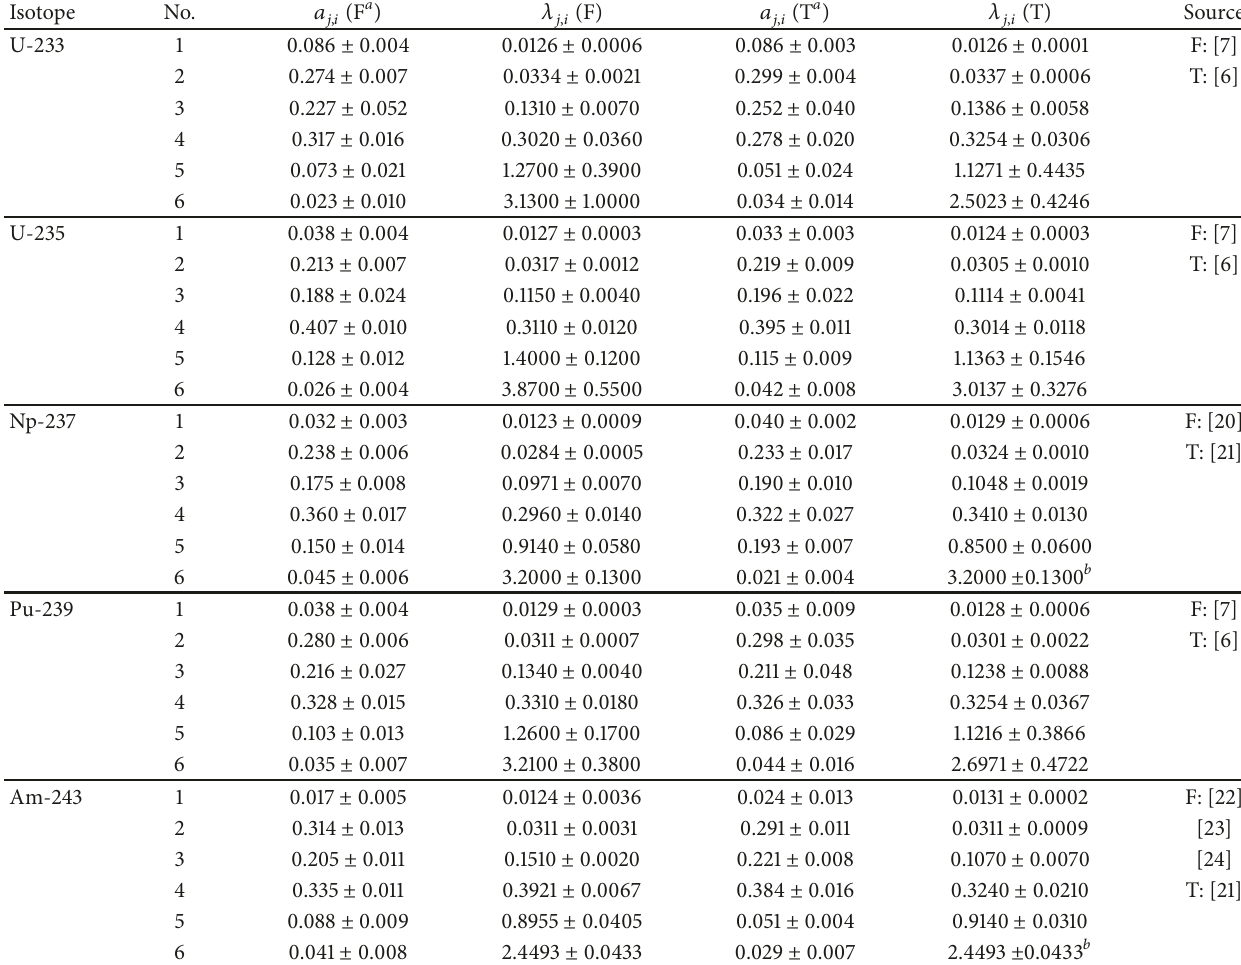
Table 1: Measured delayed neutron group parameters for the isotopes whose delayed neutrons are assigned to both thermal and fast sets. Isotope No.